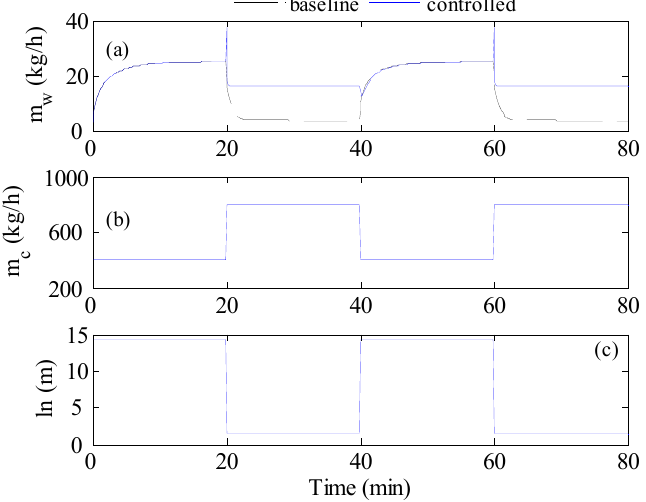
Figure 10. Optimal control results without constraints for square wave inlet hot temperature, 𝑚 (cid:3035)(cid:3036)(cid:3041) = 400 (cid:2921)(cid:2917) ;𝑇 (cid:3035) = 80 (cid:2925) C , ( a ) Productivity, ( b ) cold stream flow rate, ( c ) module length.